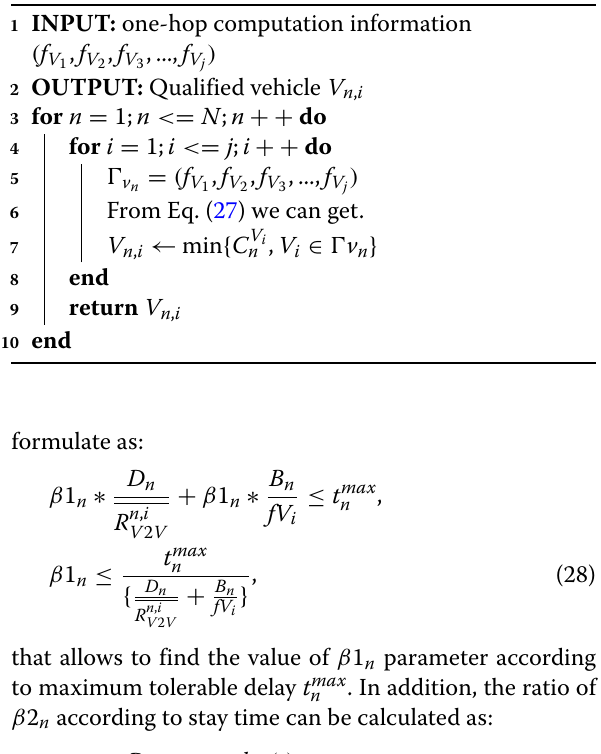
Algorithm 1: Choosing Qualified Nearby Vehicle